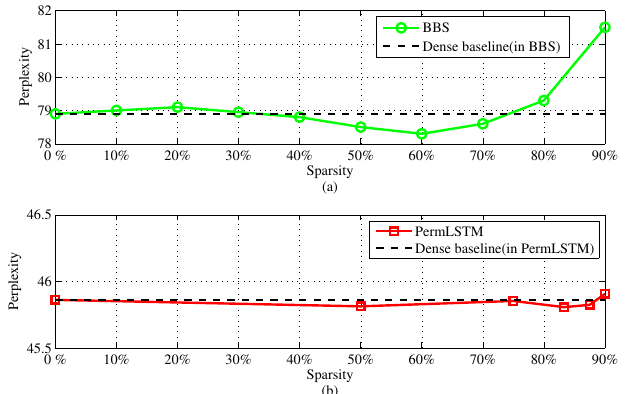
Figure 7. Perplexity vs. sparsity on the Penn Treebank (PTB) dataset. ( a ) Evaluted on BBS. ( b ) Eval- uted on